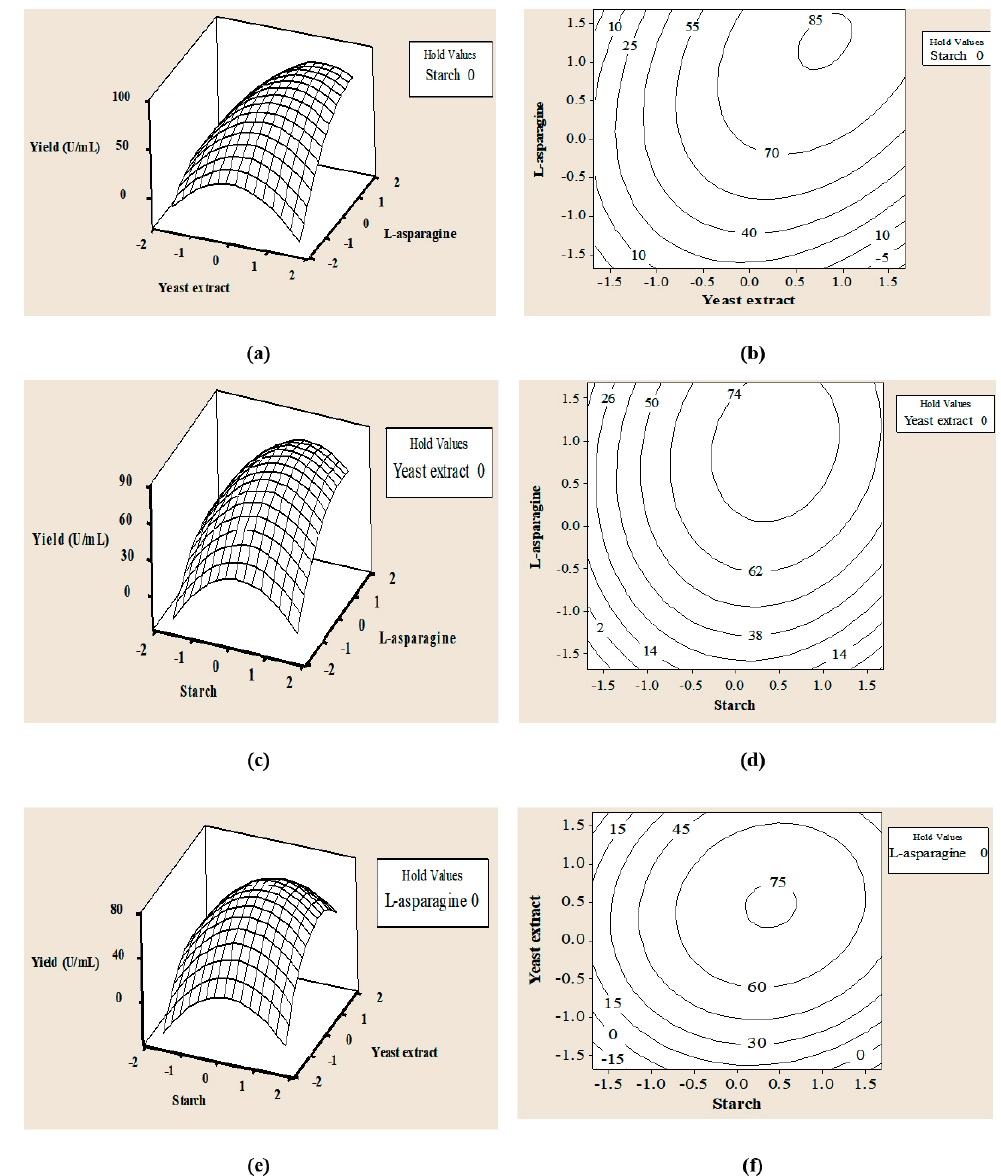
Fig. 2. Three-dimensional surface plot (a, c, e) and contour plot (b, d, f) of the effect of yeast extract and L-asparagine, starch and L-asparagine, and starch and yeast extract, respectively, on L-asparaginase production by endophytic Talaromyces